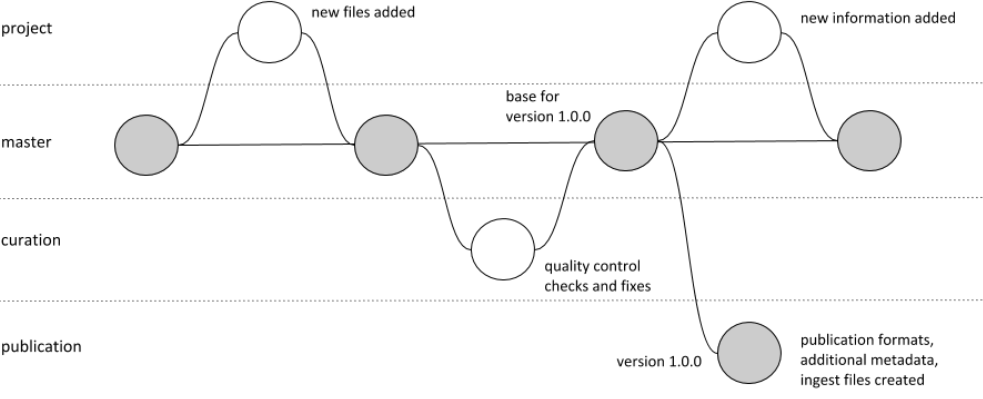
Figure 4. Version-controlled workflow for curation and publication of language